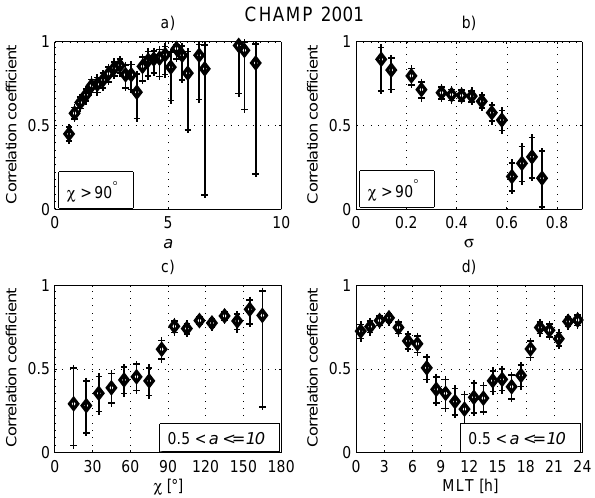
Fig. 5. Dependence of the correlation coefficient between L t and the Kp index (a) on the slope of the linear fit, a , (b) on the stan- dard deviation, σ , (c) on the solar zenith angle, χ , and (d) on the magnetic local time, MLT.